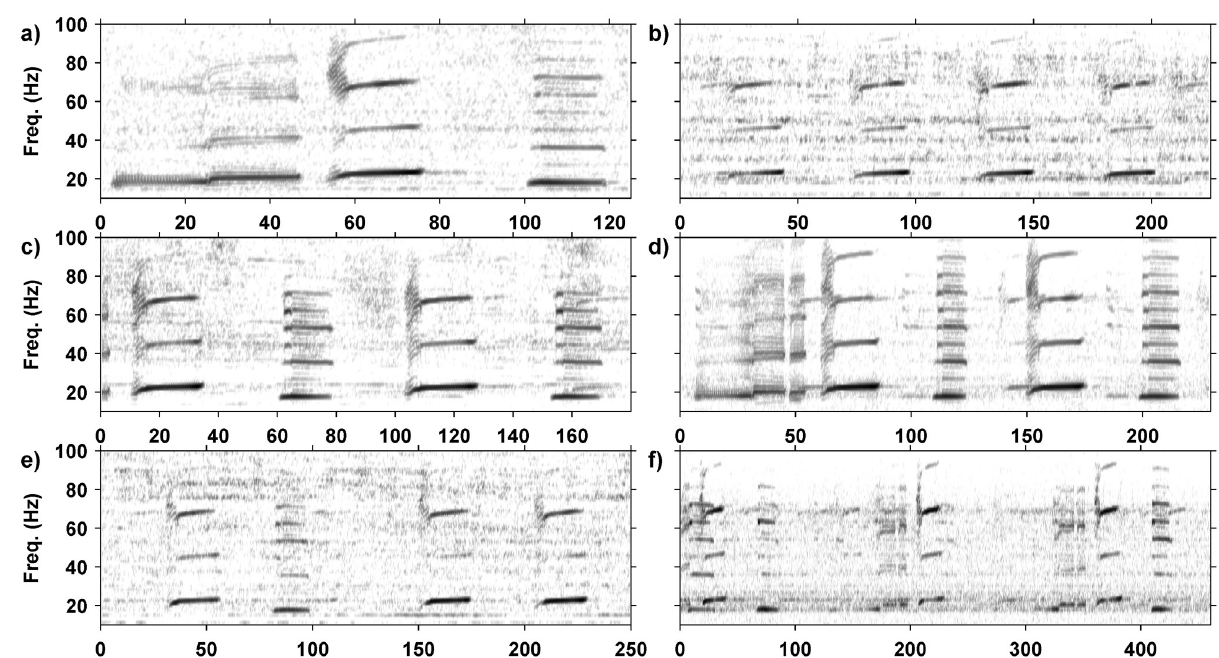
Fig 2. Spectrograms of pygmy blue whale song variants. All spectrograms made with 1024 point Fast Fourier Transform, 0.8 overlap using a 1 kHz sample rate (0.977 Hz and 0.205 s frequency and time resolution, respectively). The x-axis is time, in s, the y-axis is common for all panels. Shown are: a) one version of the normal, three unit song (P3) with the Type I (0–50 s), II (50–75 s) and III (100–125 s) units; b) the ‘song’ which repeats only the type II unit (P1); c) the song which repeats only the type II and III units (P2); d) a P3A song-type displaying a three unit song sequence followed by a two unit song sequence; e) a P2B song structure showing a two unit sequence followed by a lone type II unit and then another type II unit which marks the start of the next sequence; and f) a P3B song-type showing a three unit song sequence followed by a type I and type II unit and then another complete three unit phrase.